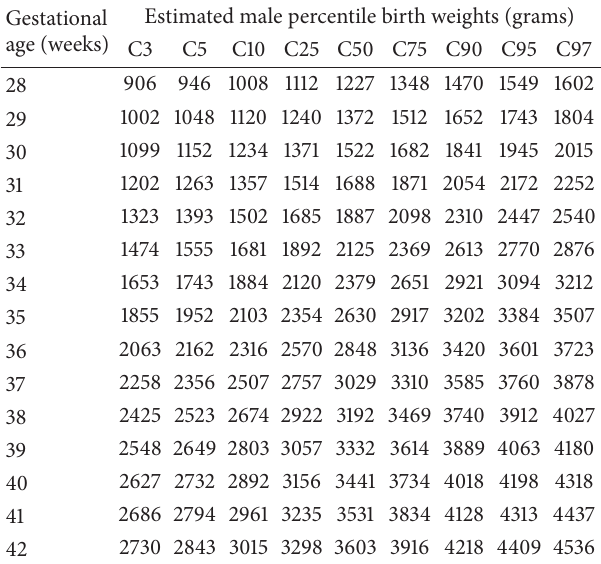
SD: standard deviation. Table 3: Estimated birth weight percentiles for gestational age for male Cameroonian